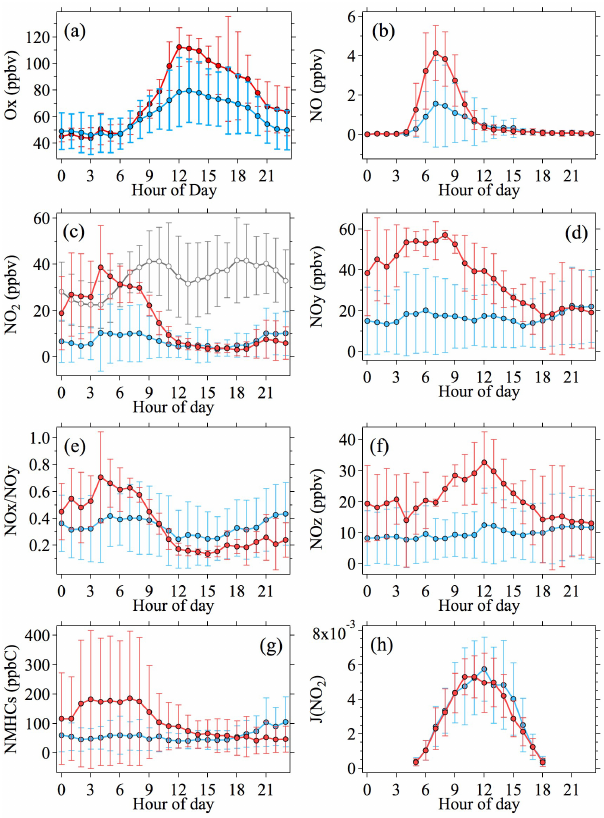
Figure 3. Diurnal variation in O x , NO, NO 2 , NO y , NO x / NO y , NO z , NMHCs, and J (NO 2 ) during the field campaign. The red and blue colors represent the averaged diurnal patterns for the high- O 3 pollution (hourly O 3 mixing ratio > 100ppbv even only once in a day) and low-O 3 pollution (hourly O 3 mixing ratio < 100ppbv) days, respectively. The gray line in (c) indicates the NO 2 concen- tration in the downtown area of the Shanghai